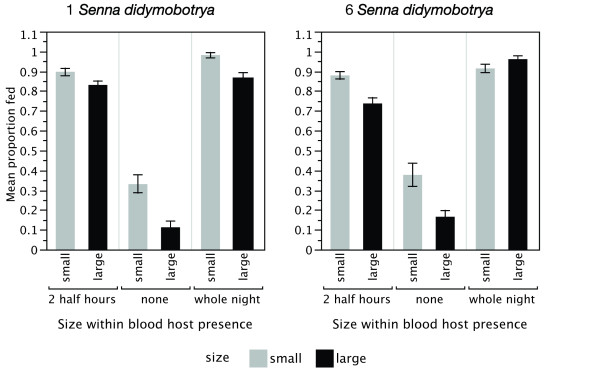
Proportions ± SEM of small and large females that fed on at least one food item (i.e. blood or sugar or both) compared with nothing, according to blood-host exposure. Both plant densities and all replicates are combined.